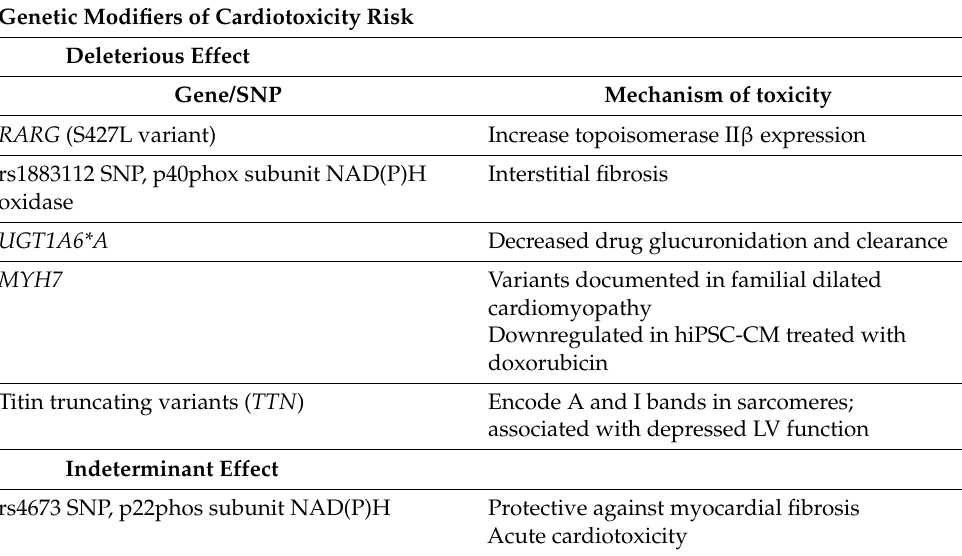
Table 1. Overview of genetic modifiers of cardiotoxicity risk. Genetic Modifiers of Cardiotoxicity